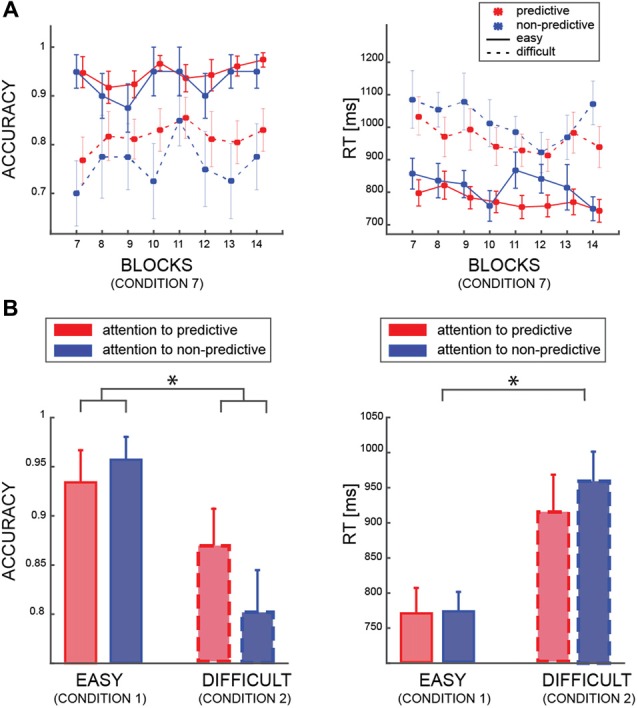
(A) Averaged accuracy and reaction time (RT) results for the easy (solid lines) and difficult (dashed lines) trials, and for predictive (red) and non-predictive (blue) trials. All data are from trials in which the patches are identical (condition 7—see Table 1). (B) Averaged accuracy and RT results according to which patch was attended by participants (same color code as in “a”) in trial from condition 1 and condition 2 (see Table 1). In all panels, error bars are standard errors, and asterisks indicate significant difference (p < 0.05).